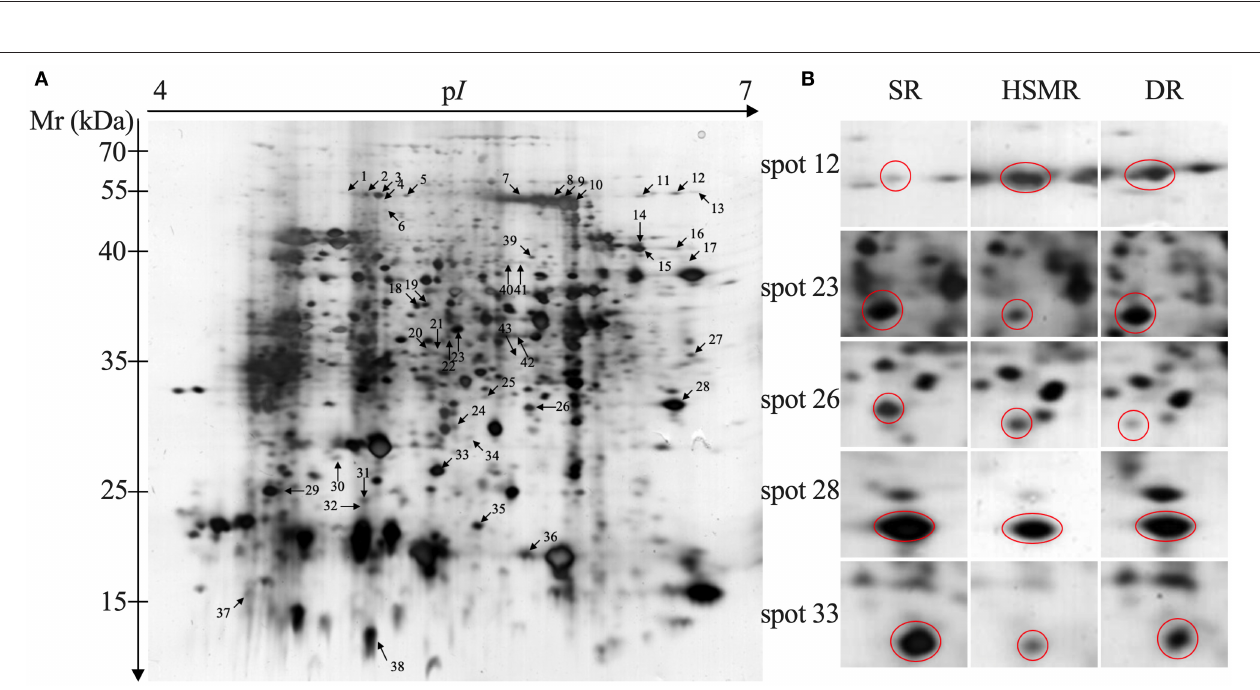
FIGURE 3 | Scanning electron micrographs (800 × ) of the leaf surface of the three reed ecotypes (Bar = 100 µ m). (A) SR, swamp reed; (B) HSMR, heavy salt meadow reed; (C) DR, dune reed; (D) stomatal density; and (E) stomatal aperture on leave surfaces of the three reed ecotypes. Different lowercase letters at the data indicate significant differences among three different ecotypes of reed at p < 0.05 (one-way ANOVA).